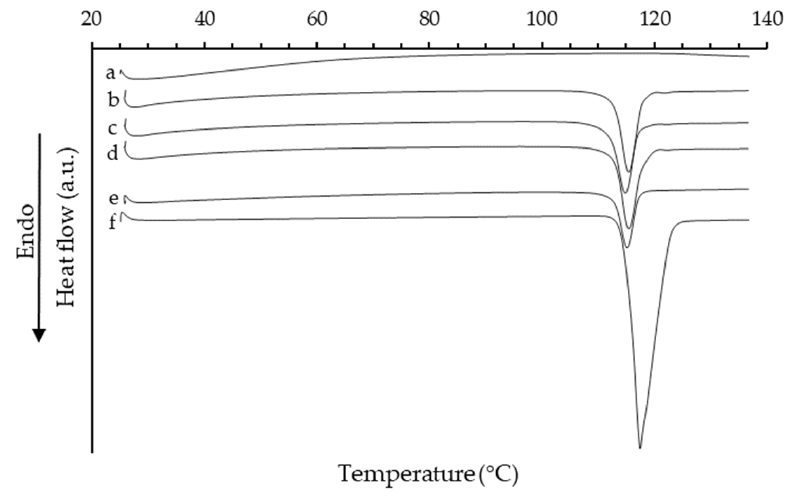
Figure 10. DSC thermograms of H (a), CH (b), CH_HCl_8M (c), CH_H 2 SO 4 _0.5M (d), CH_NaOH_0.5M (e), and C (f).